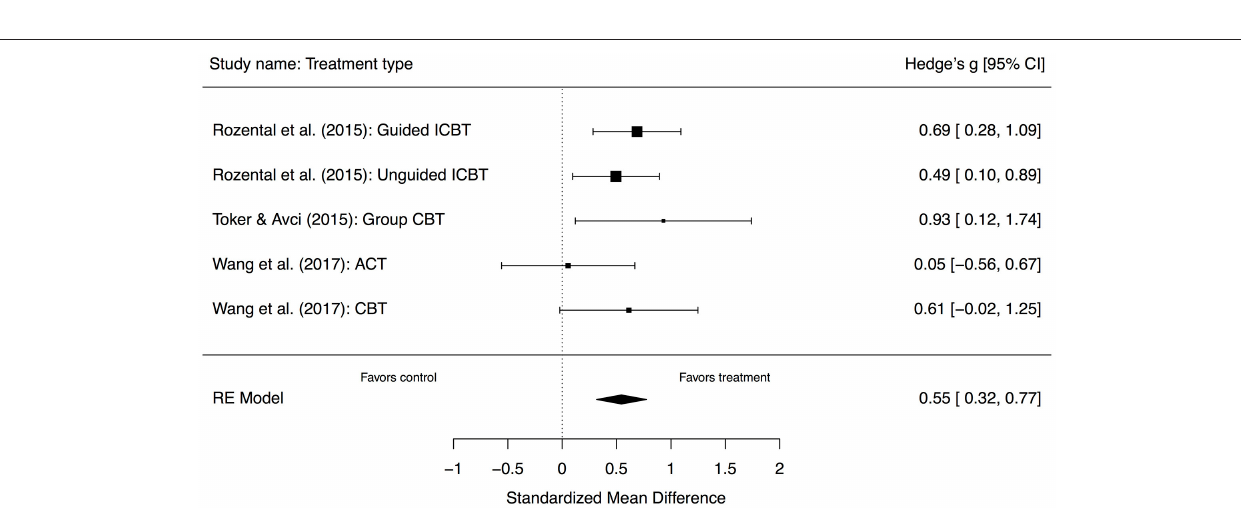
CBT, and − 0.29, 95% CI [ − 1.14, 0.58] for individual